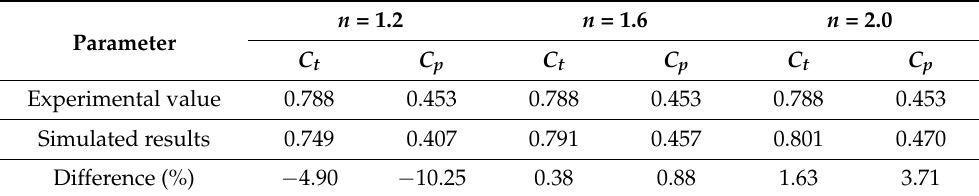
Table 4. Comparison of thrust and power coefficients of a wind turbine under different smoothing